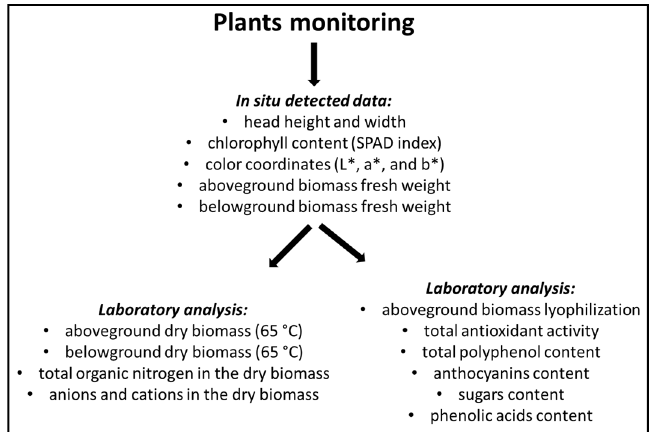
Figure 4. Plant monitoring scheme.